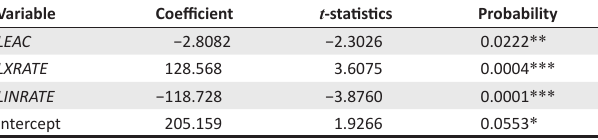
TABLE 4: Autoregressive distributed lag long-run estimates.